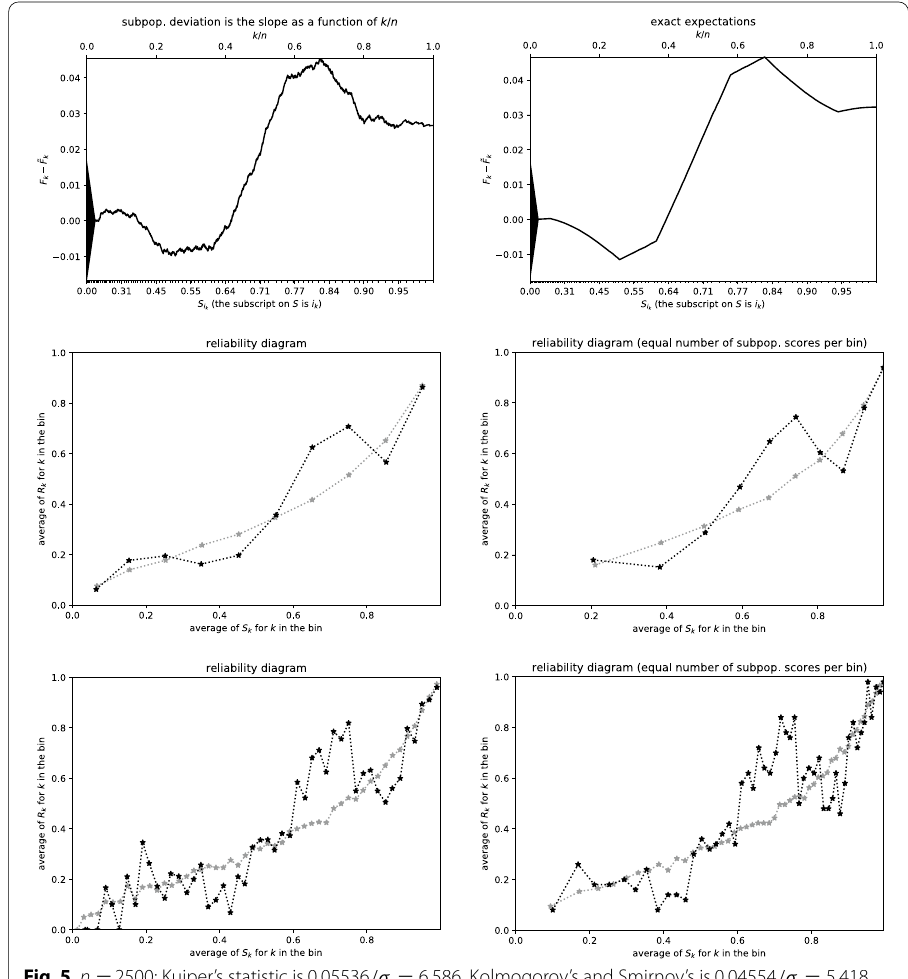
Fig. 5 n = 2500; Kuiper’s statistic is 0.05536 /σ = 6.586 , Kolmogorov’s and Smirnov’s is 0.04554 /σ = 5.418 . Figure 6 displays the ground-truth reliability diagram. The observed reliability diagrams fail to depict the underlying discontinuous jumps in the subpopulation’s expected outcomes as a function of the score. The plot of cumulative deviation succeeds in resolving some of the corresponding cusps, but does exhibit significant random fluctuations nearly as high as a quarter of the height of the triangle at the origin. The scalar summary statistics successfully detect the statistically significant deviation of the subpopulation from the full